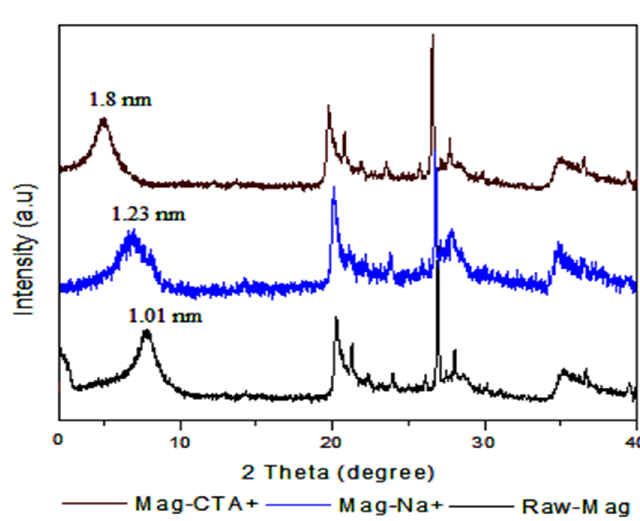
Figure 2. XRD patterns of Raw-Mag, Mag-Na + and Mag-CTA + .